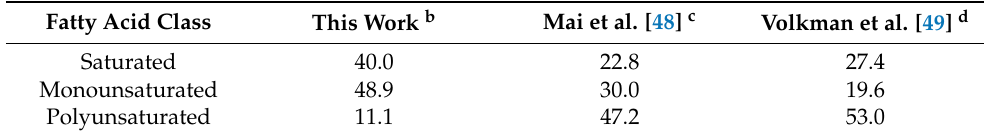
Table 4. Percentages of different fatty acid classes a in total fatty acids of T. pseudonana . Fatty Acid Class This Work b Mai et al. [48] c Volkman et al. [49] d Saturated 40.0 22.8 27.4 Monounsaturated 48.9 30.0 19.6 Polyunsaturated 11.1 47.2 53.0 a All data were based on the total fatty acids being the sum of saturated, monounsaturated, and polyunsaturated fatty acids. Non-fatty acid components were not included. b Grown mixotrophically in 20% POME medium (80 µ M Na 2 SiO 3 and 35 g NaCl L − 1 ; 26 ± 1 ◦ C, 15 days; 16:8 h:h light–dark cycle, 200 µ mol photons m − 2 s − 1